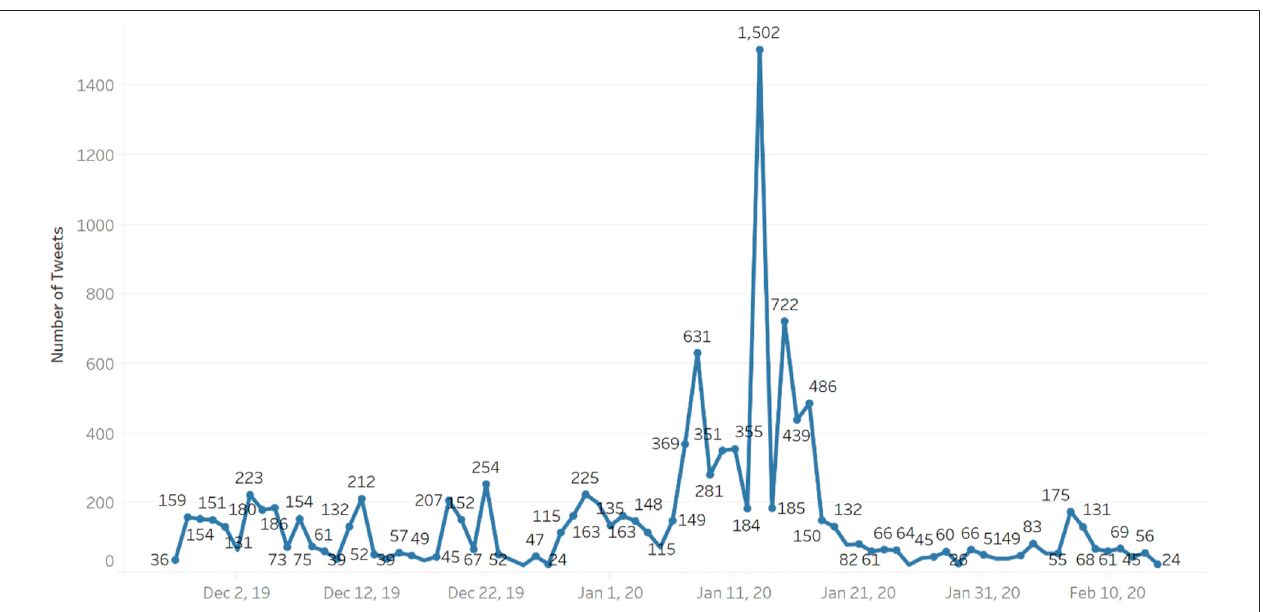
FIGURE 1 | Frequency of tweets referencing climate change and/or global warming in the dataset.